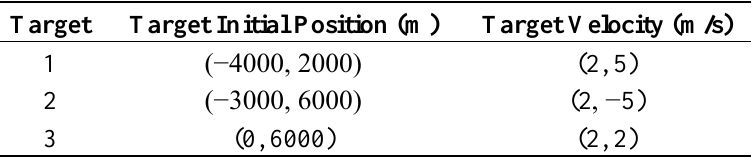
Figure 2. Three target tracks for 200 scans for one receiver: ( a ) Six transmitters; ( b ) Three transmitters. Table 1. The three targets’